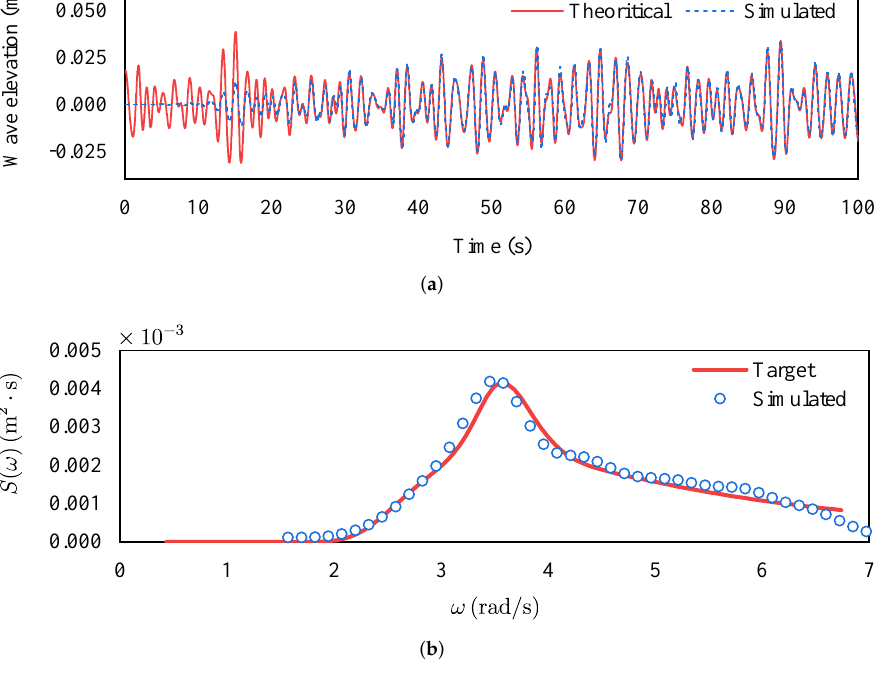
Figure 7. Simulation results of the JONSWAP case (color figure available online). ( a ) Profile of the wave elevation monitored by the wave gauge at x = 6.0m. ( b ) Comparison between the target spectrum and the simulated